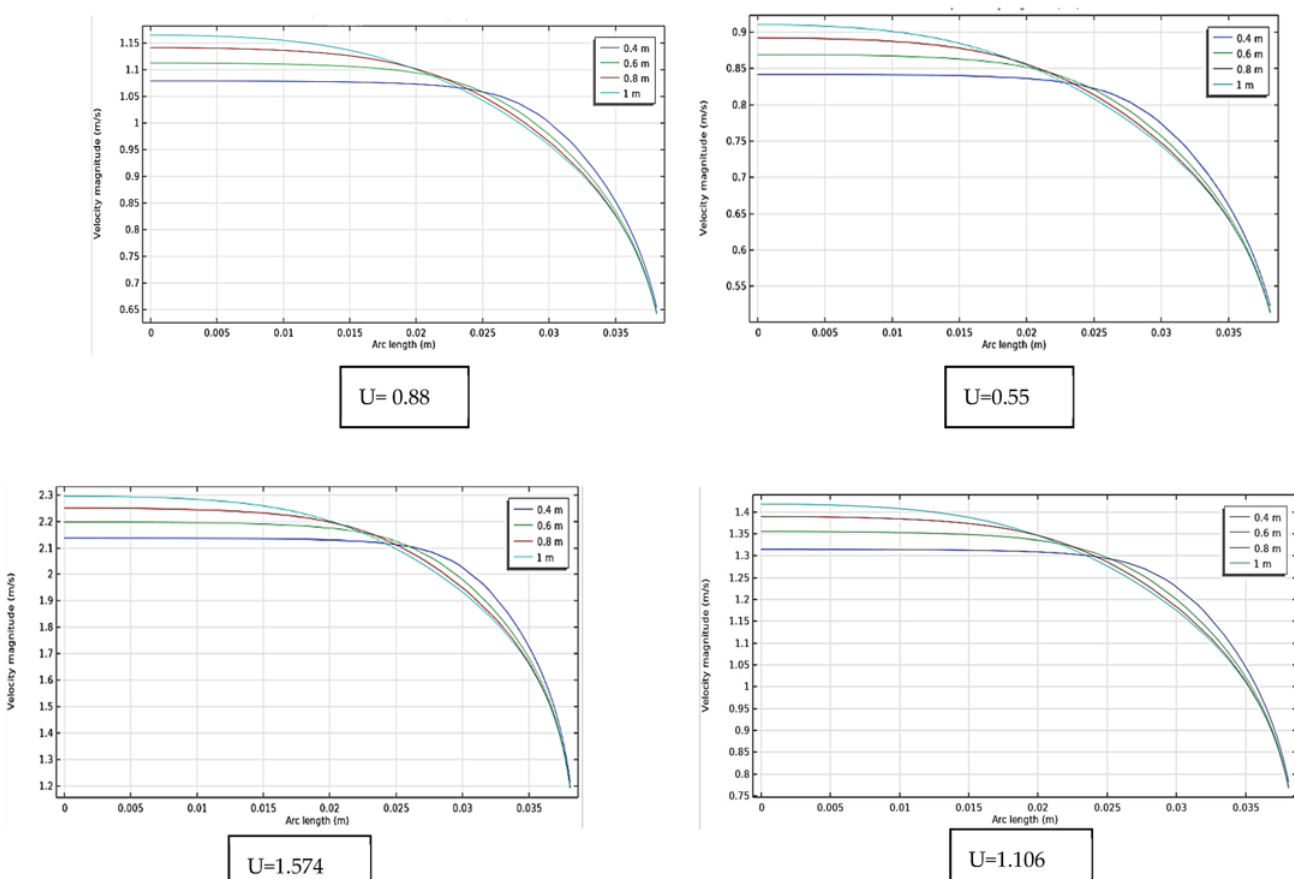
Figure 9. Velocity variation along the 1-m-long pipeline with 600 ppm XGs.